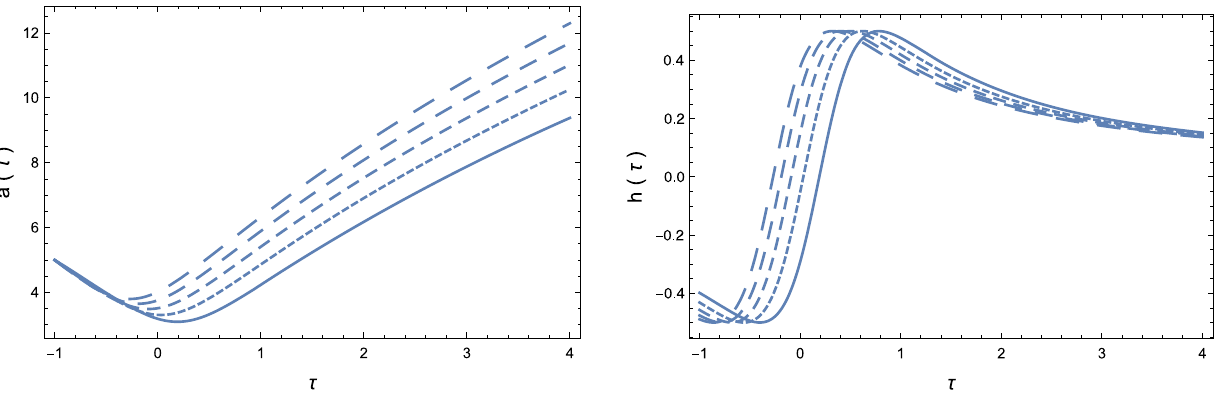
A 4 = 6 × 10 − 58 (short dashed curve), A 4 = 7 × 10 − 58 (dashed curve), and A 4 = 8 × 10 − 58 (longdashedcurve),respectively.Theinitialcondi- tions used to numerically integrate Eqs. (71) and (72) are θ (τ 0 ) = θ 0 = −√ 2 × 10 58 , and h 0 = 0 . 04943 A 4 θ 0 ( 1 − 0 . 04943 A 4 θ 0 ) ,